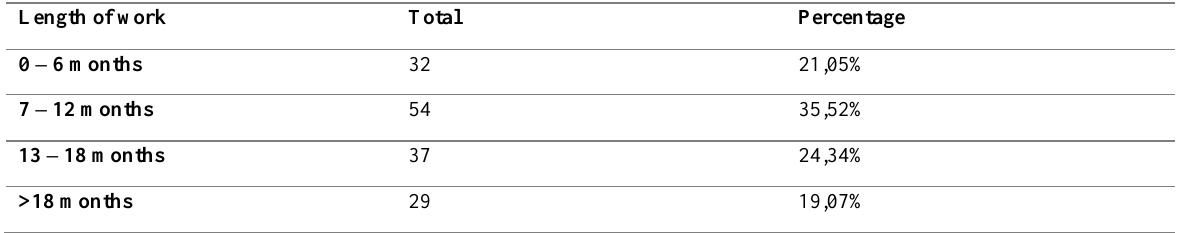
Table 3: Respondents with work